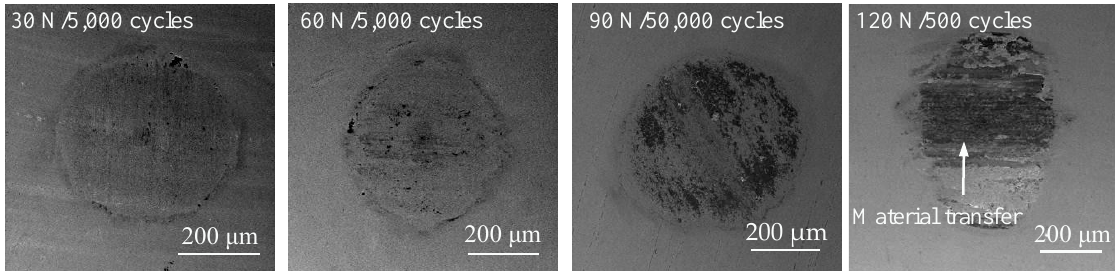
Figure 12. Wear scar of the counterbody against the CrN-coated WC-Co substrate under different condition.